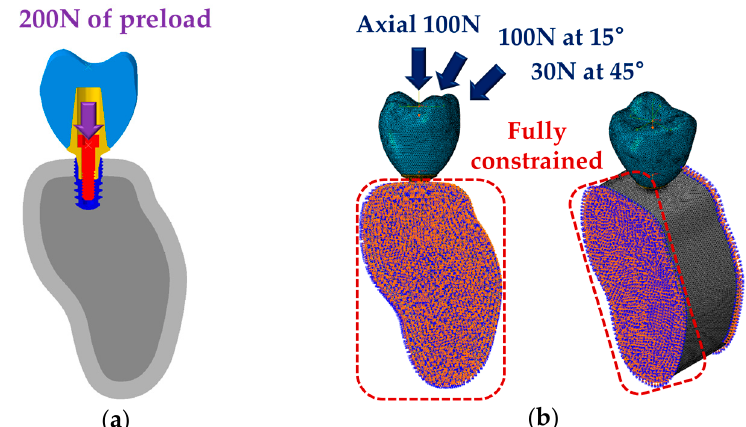
Figure 3. Loading and boundary conditions of single surgical models (conventional and separable fixture types). ( a ) Application of preload of 200N at abutment screw assuming the connection state of abutment and fixture. ( b ) Application of 100N (axial), 100N (15°), and 30N (45°) considering the various directional loads applied to